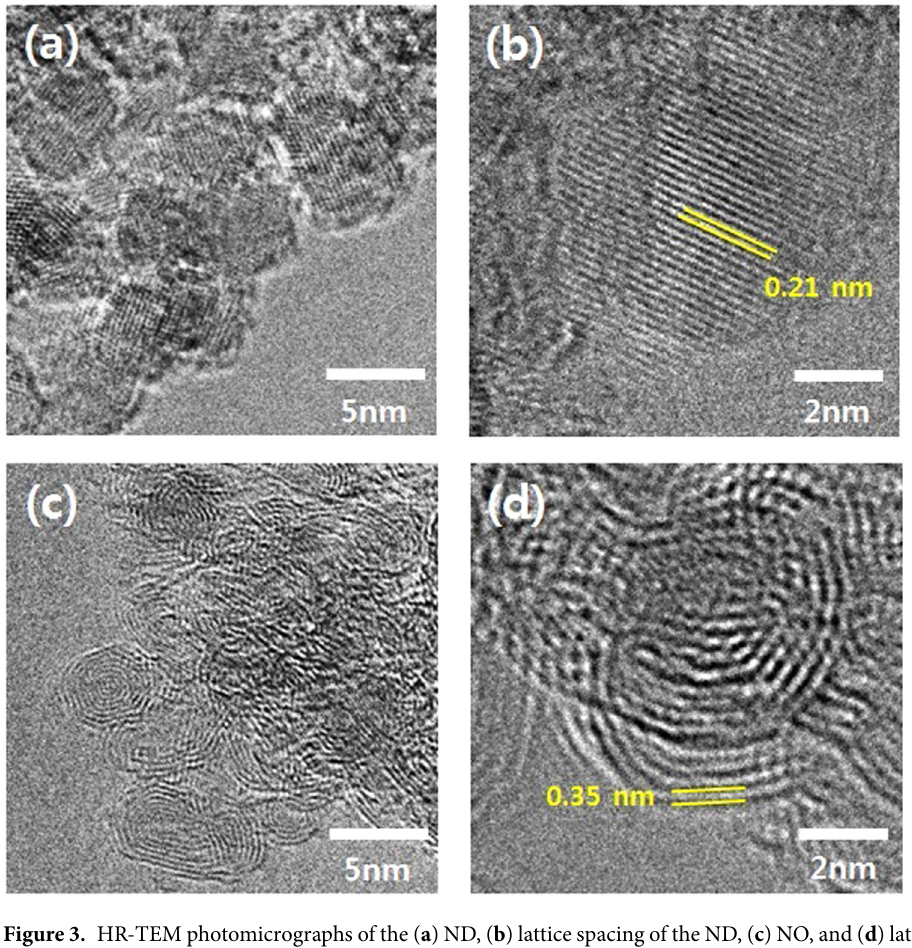
Figure 3. HR-TEM photomicrographs of the ( a ) ND, ( b ) lattice spacing of the ND, ( c ) NO, and ( d ) lattice spacing of the NO.